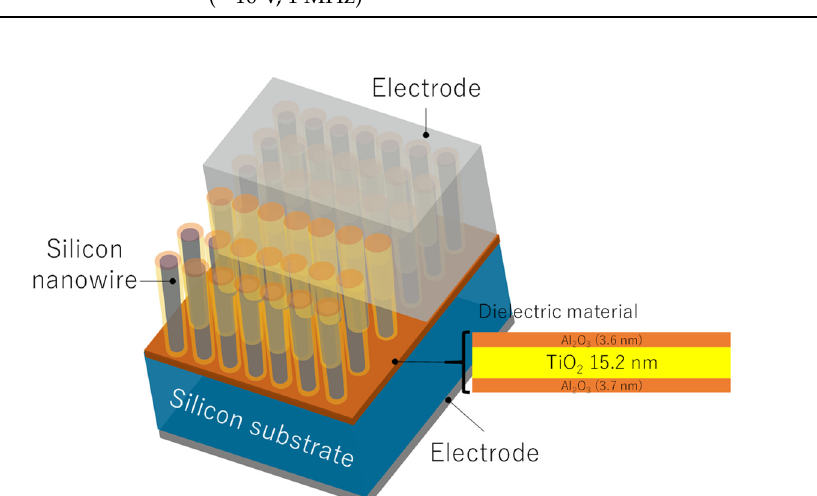
Figure 1. Schematic diagram of a fabricated SiNW MOS capacitor. The insulator consists of an